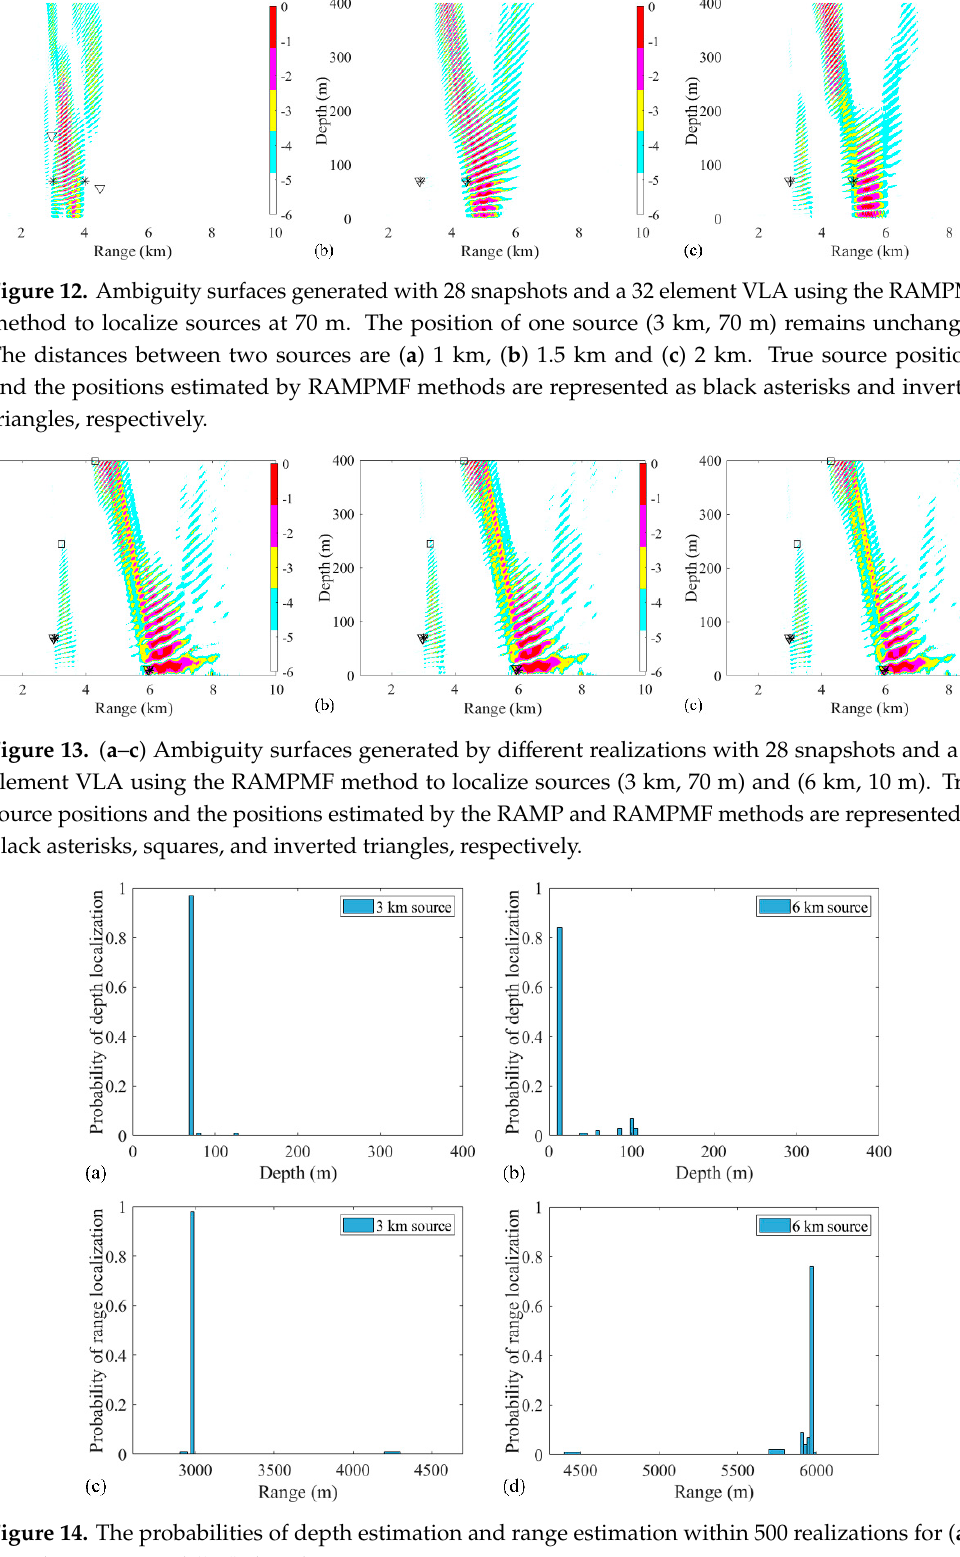
Figure 14. The probabilities of depth estimation and range estimation within 500 realizations for ( a , c ) the 3 km source and ( b , d ) the 6 km source. the 3 km source and ( b , d ) the 6 km